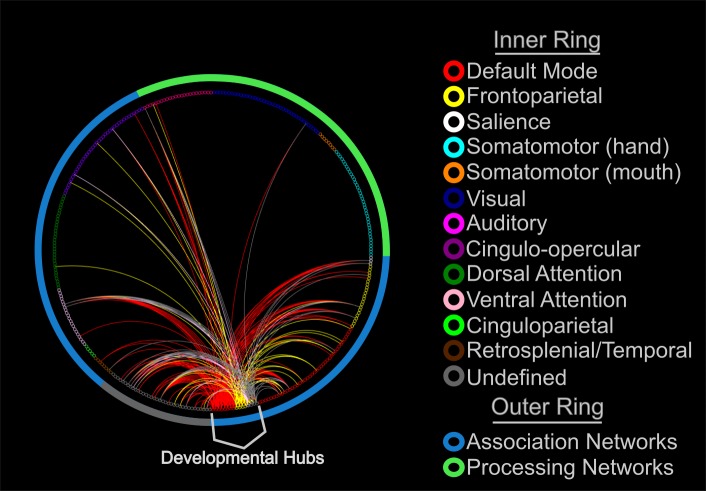
Pairwise age-related decreases in resting-state phase-locking.Pairwise increases in decoupling between the top 5% of brain regions that showed age-related increases in decoupling (developmental hubs) and their respective top 5% pairwise interactions. Regions (little circles) are colored by the network to which they are affiliated. Link color represents the network affiliation to which the developmental hub belonged. The most significant pairwise increases occurred between regions of the DM, and FP networks to other association networks. DM, Default Mode; FP, Frontoparietal.